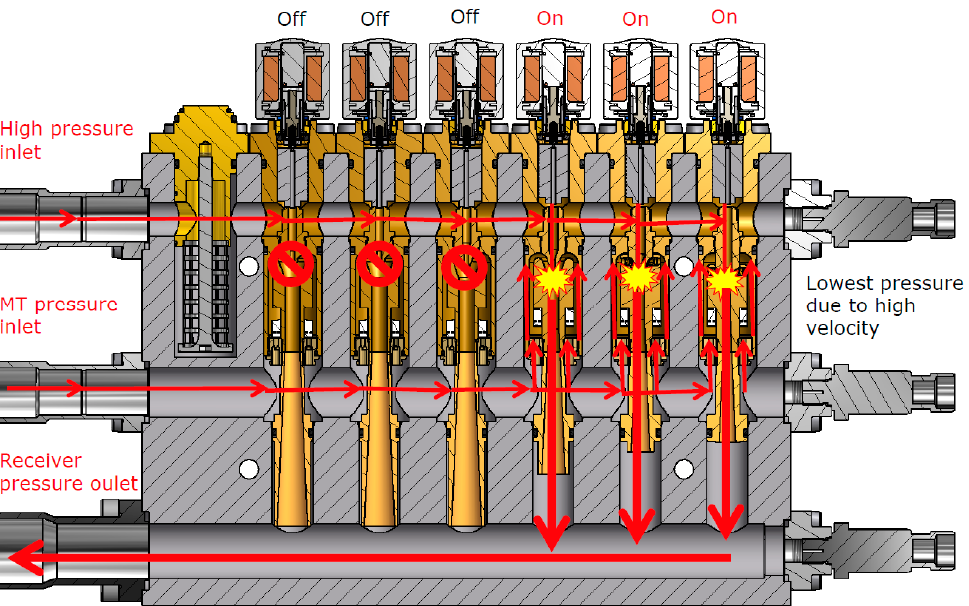
Figure 2 Sketch of the multi-ejector block [16]. Figure 2. Sketch of the multi-ejector block